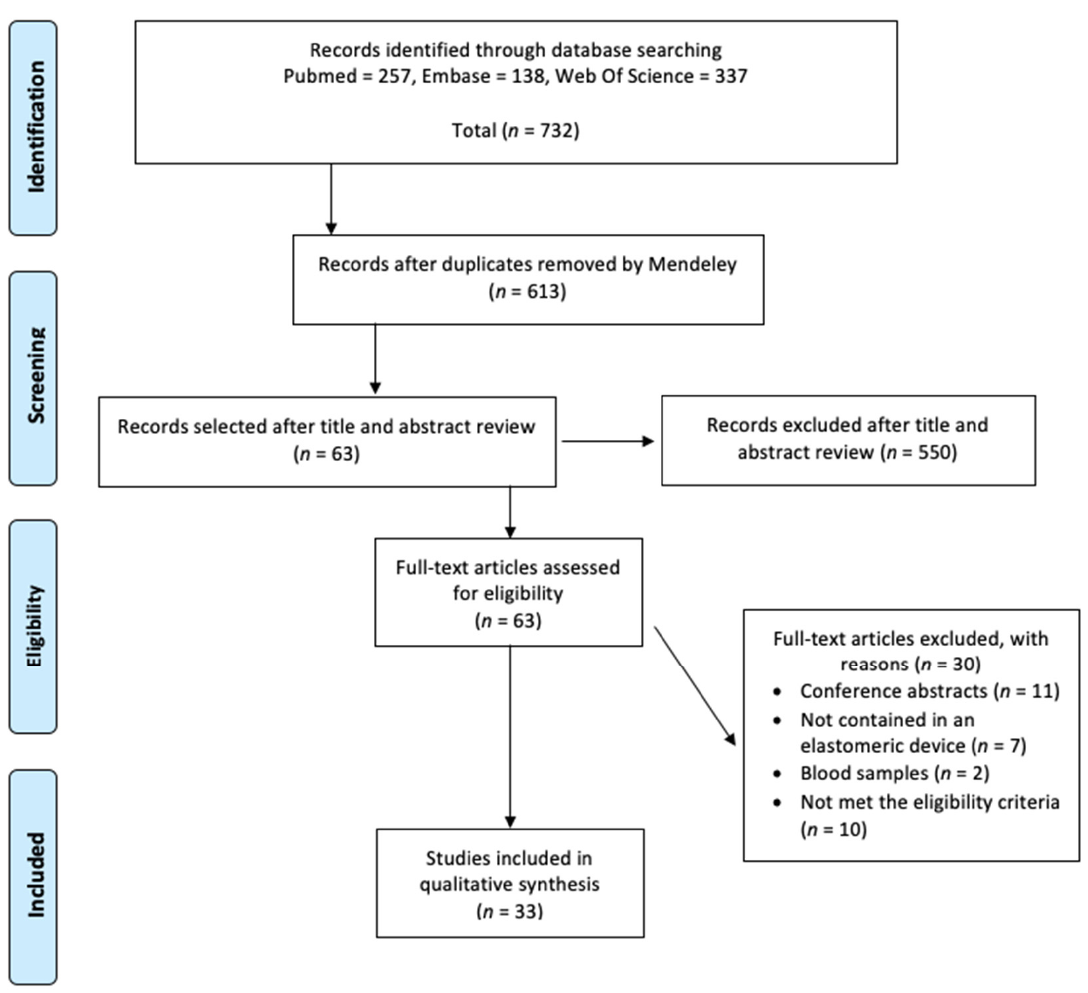
Figure 1. Study selection flowchart .